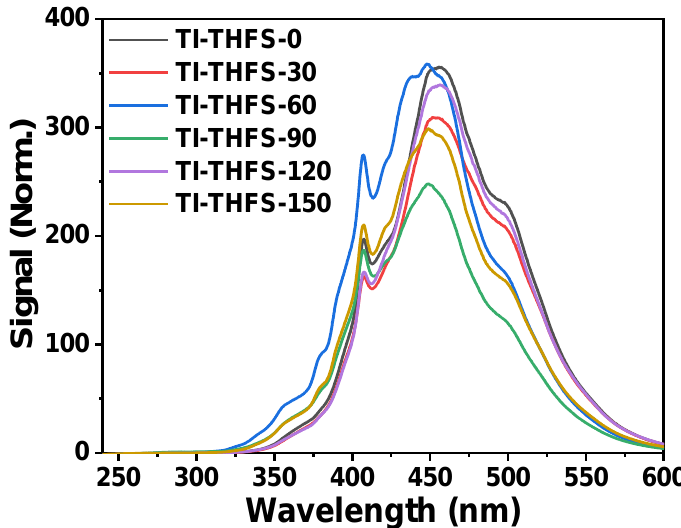
Figure 11. Synchronous fluorescence spectra of the TI-THFS fraction.